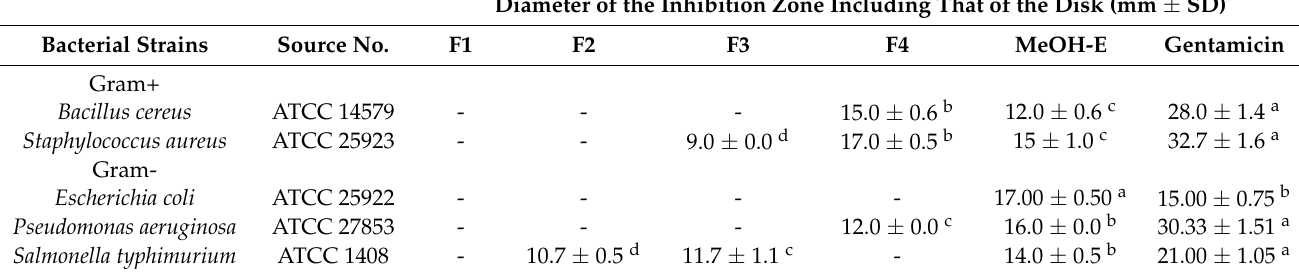
Table 5. Antibacterial activity of R. raetam MeOH-E, fractions F1, F2, F3, F4 and antibiotic (at 100 µ g/mL), against five human pathogenic bacteria. Inhibition zone (IZ) calculated as diameter around the disc